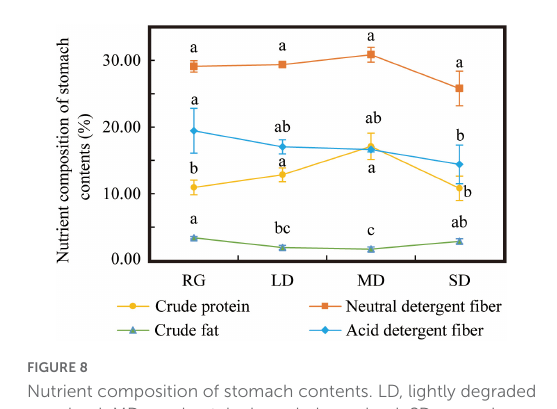
FIGURE9 Structural equation model between plateau zokor density and soil physical properties, plant resources, and feeding habits. Dotted line indicates that the effect is insignificant and the black line indicates a negative correlation. ∗ P < 0.05, ∗∗∗ P <